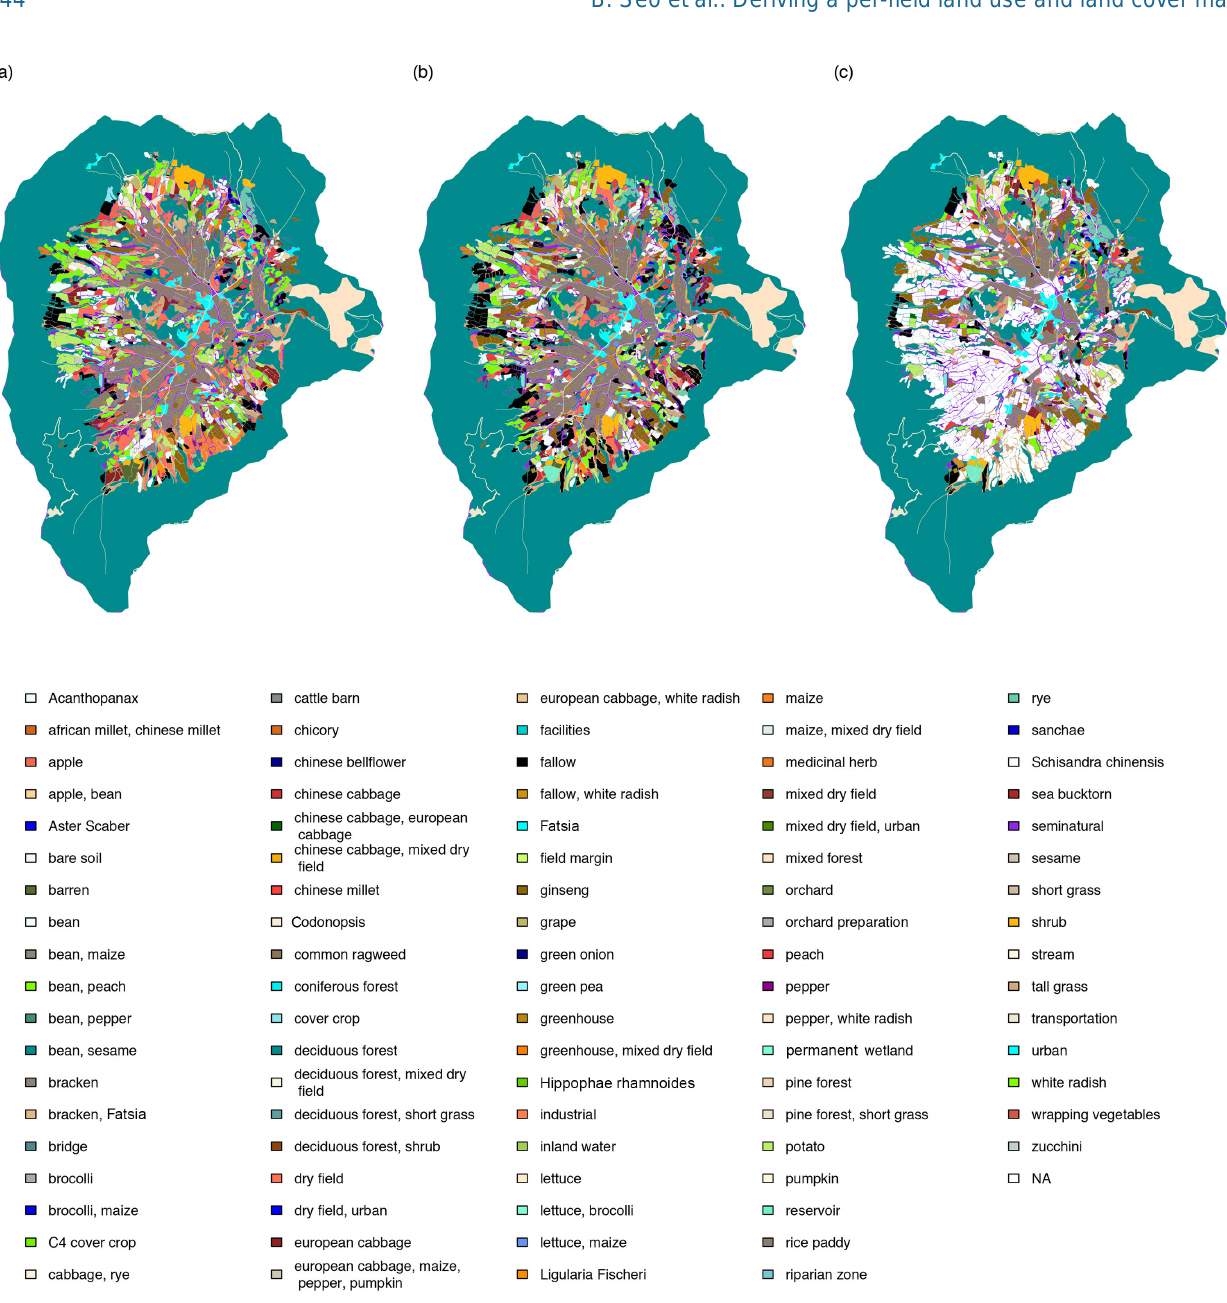
Figure 1. Land use and land cover in the Haean catchment in (a) 2009, (b) 2010 and (c) 2011 according to the classification scheme S1 containing 67